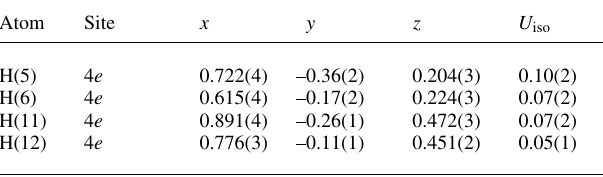
Table 2. Atomic coordinates and displacement parameters (in Å 2 )